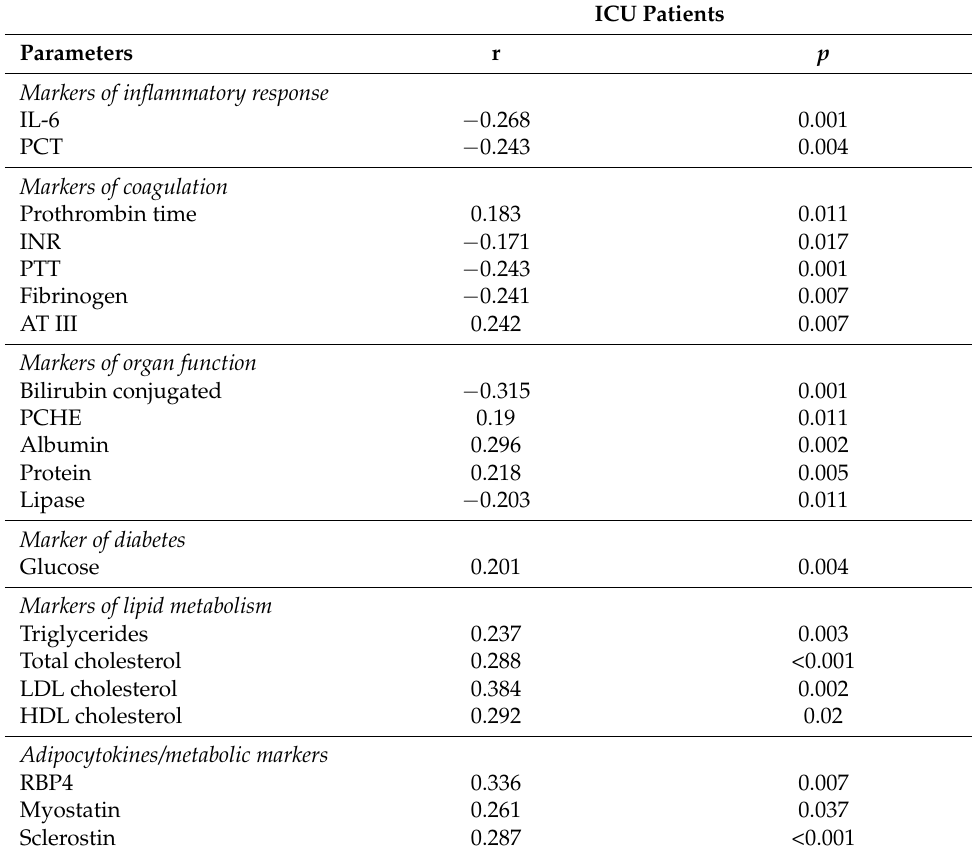
Table 3. Correlations of laboratory parameters with clusterin plasma concentrations (Spearman rank correlation test; only significant results are shown).